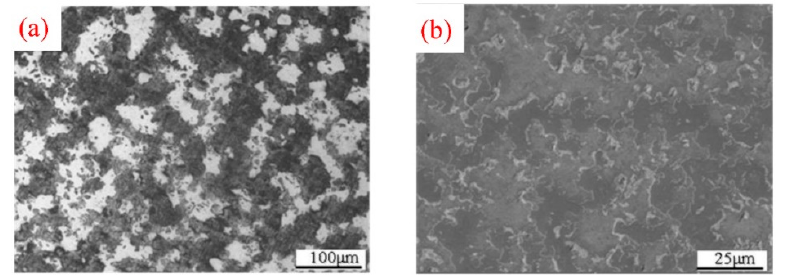
Figure 6. Microstructures of sintered Zr-6Al-0.1B alloy: ( a ) OM image; ( b ) SEM image.